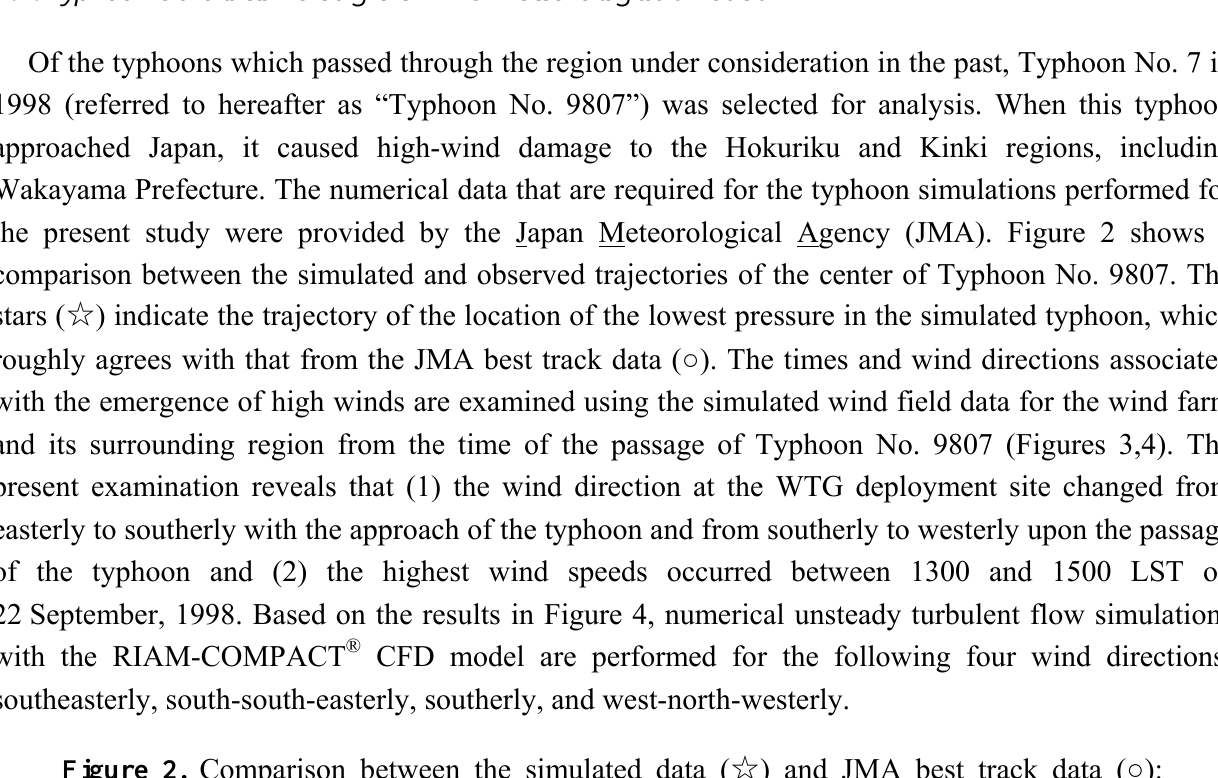
Figure 2. Comparison between the simulated data ( ☆ ) and JMA best track data ( ○ ): trajectory of the location of the lowest pressure in Typhoon No.